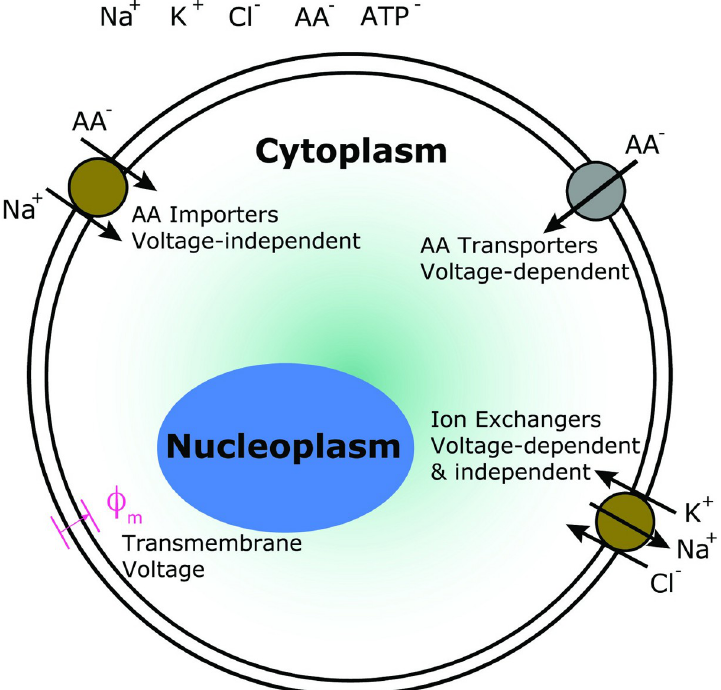
Fig 2. The cell volume is proportional to the impermeable macromolecular number (proteins, buffers, and ribosomes) because the concentration of small charged molecules such as amino acids and ATP are likely regulated together with concentration of ions. For example, amino acids can be imported into the cytoplasm together with Na + in a voltage independent manner, or imported individually in a voltage dependent manner. The also depends on ion concentration (Na + , K + , Cl − , etc). Models of cell ionic homeostasis transmembrane voltage ϕ m predict that the cell water content is directly proportional to cell macromolecular number.